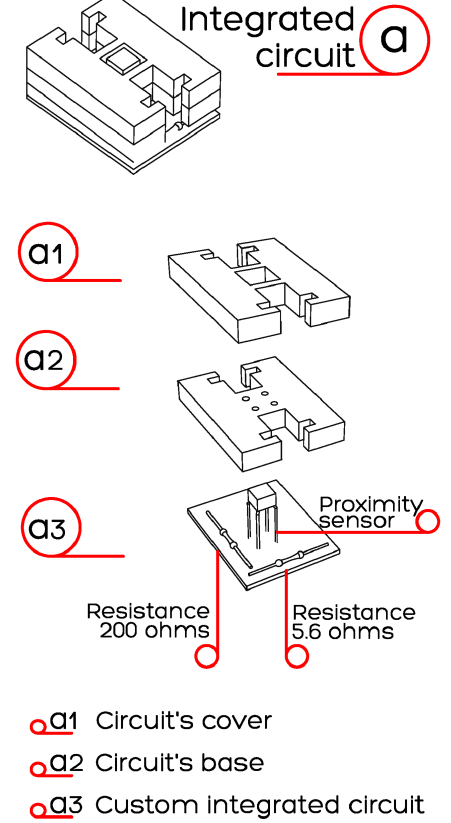
Figure 5. Integrated Circuit